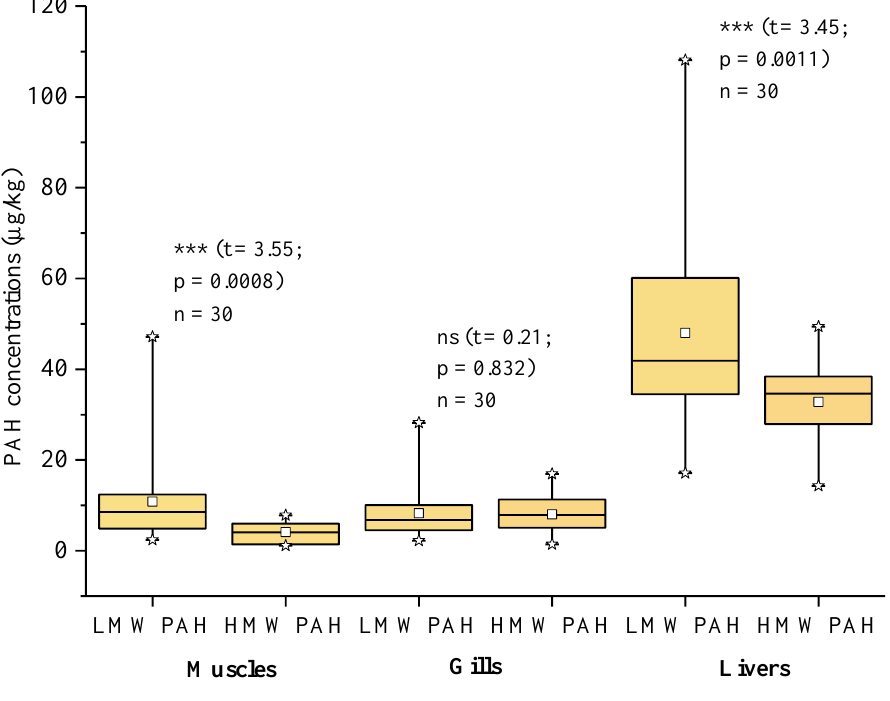
Figure 3. Boxplot diagrams of LMW and HMW PAHs concentrations in fish organs. Note: ***: Significant test ( p < 0.05), ns: non-significant test ( p > 0.05).